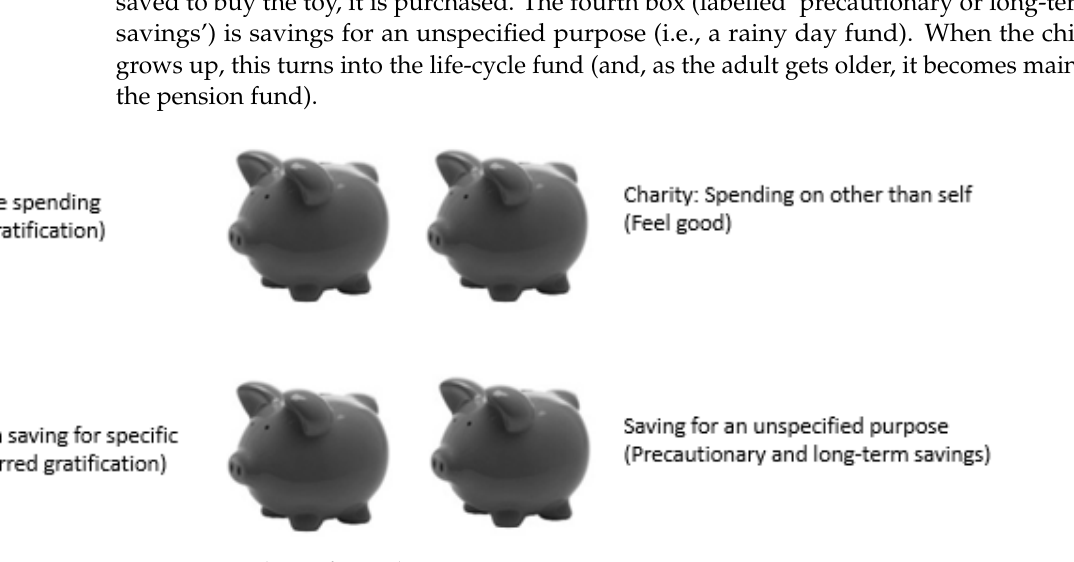
Figure 5. Four boxes for pocket